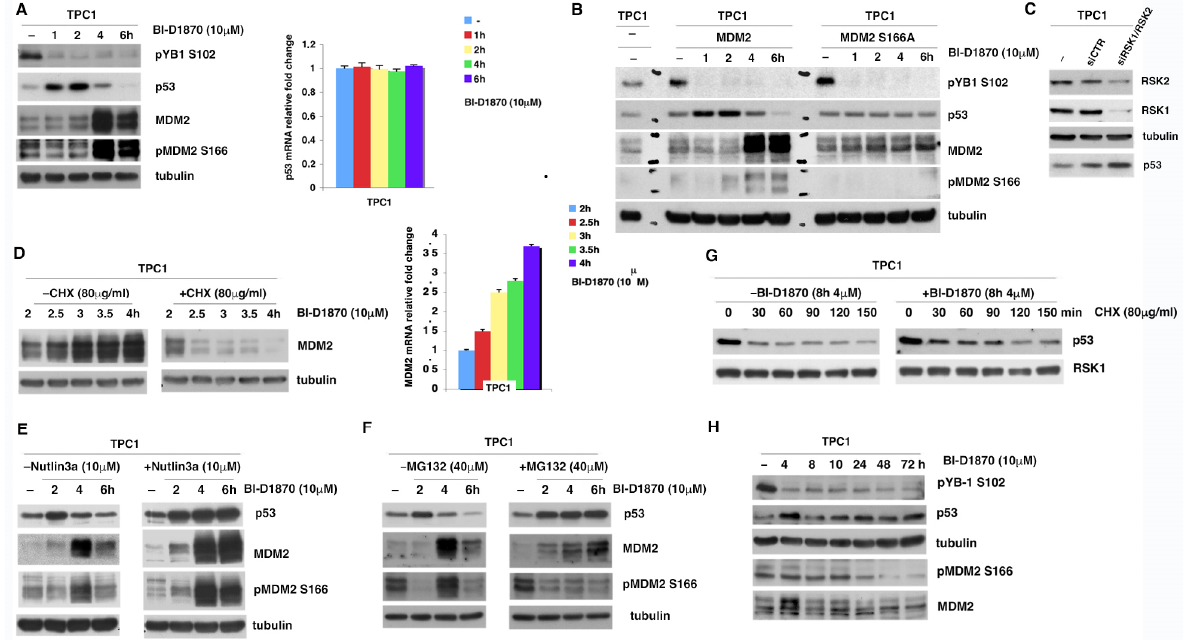
Figure 4. p90RSK promotes degradation of p53 via MDM2 phosphorylation. ( A ) TPC1 cells were treated with 10 µ M BI-D1870 at the indicated times. The efficacy of the treatment was verified with anti-phospho-S102 YB1 antibody. The immunoblot was then tested with anti-p53, anti-MDM2 and anti-phospho-S166 antibodies and normalization was performed by immunoblotting with anti-tubulin antibody (left panel); analysis of p53 mRNA levels by quantitative RT-PCR in TPC1 cells treated with BI-D1870 at the indicated times. The experiment was conducted in triplicate and the standard deviations are represented by the diagram error bars (right panel); ( B ) TPC1 cells were transfected with MDM2wt or MDM2 S166A expression vectors, after 24 h cells were starved for 12 h and then treated with 10 µ M BI-D1870 for the indicated times (h). The efficiency of transfection was verified with anti-MDM2 antibody compared with non-transfected TPC1 cells ( − ). The effectiveness of the treatment was verified with anti-phospho-S102 YB1 antibody. The immunoblot was then tested with anti-p53 and anti-phospho-S166 MDM2 antibodies and normalization was performed by immunoblotting with anti-tubulin antibody; ( C ) TPC1 cells were transfected with RNA interference against RSK1 and RSK2 (pool of specific RSK1/RSK2 siRNAs) or with control RNA interference (siCTR). The interference efficiency was verified with anti-RSK1 and anti-RSK2 antibodies. p53 total level was revealed with anti-p53 antibody. Normalization was performed by immunoblotting with anti-tubulin antibody; ( D ) TPC1 cells were pretreated with 10 µ M BI-D1870 for 2 h and co-treated, or not, with cycloheximide at indicated times. The immunoblot was tested with anti-MDM2 antibody and normalized with anti-tubulin antibody (left panel); analysis of MDM2 mRNA levels by quantitative RT-PCR in TPC1 cells treated with BI-D1870 at the indicated times. The experiment was conducted in triplicate and the standard deviations are represented by the diagram error bars (right panel); ( E ) TPC1 cells were treated with BI-D1870 10 µ M with or without Nutlin-3 at the indicated times. The immunoblot was tested with anti-p53, anti-MDM2, and anti-phospho-S166 antibodies and normalized with anti-tubulin antibody; ( F ) TPC1 cells were treated with 10 µ M BI-D1870 with or without MG132 at the indicated times. The immunoblot was tested with anti-p53, anti-MDM2, and anti-phospho-S166 antibodies and normalized for tubulin; ( G ) TPC1 cells were treated with BI-D1870 4 µ M for the total hours indicated (8 h) and treated with cycloheximide (CHX) for different times (min). The immunoblot was tested with anti-p53 antibody and normalized with anti-RSK1 antibody; ( H ) TPC1 cells were treated with 4 µ M BI-D1870 for the indicated times (h). The efficacy of the treatment was verified with anti-phospho-S102 YB1 antibody. The immunoblot was then tested with anti-p53, anti-MDM2, and anti-phospho-S166 MDM2 antibodies and normalized for